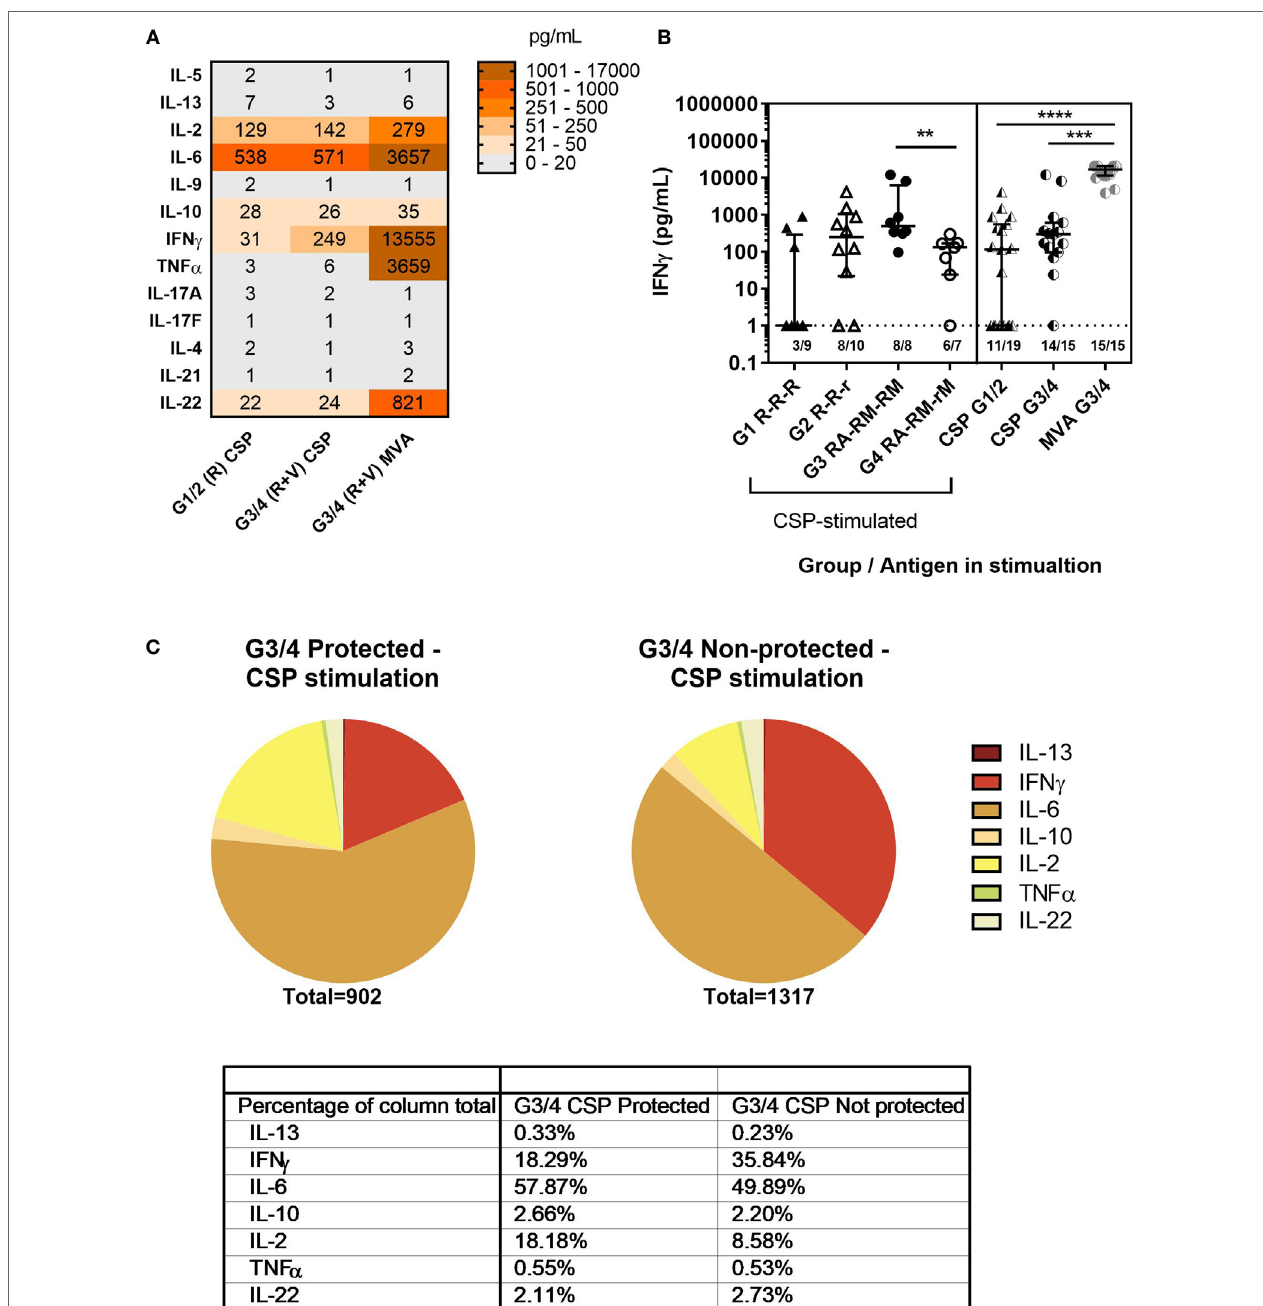
FigUre 5 | Cytokine responses to CSP and MVA. Cytokine responses measured in supernatant after stimulation of 1–2 × 10 6 PBMC at C-1 with CSP or MVA. A multiplex cytokine bead assay (Legendplex, BioLegend) was used to measure a panel of T-helper cytokines. Responses were measured for 19 G1/2 samples stimulated with CSP and 15 G3/4 samples for which there were enough cells to run both CSP and MVA stimulations. (a) Heatmap of geomean cytokine concentrations in pg/mL in supernatant of PBMC from G1/2 stimulated with CSP and G3/4 stimulated with CSP or MVA. (B) Concentration of IFN γ in supernatant of PBMC stimulated with CSP or MVA, Kruskal–Wallis with Dunn’s multiple comparisons P < 0.0001. Mann–Whitney analysis between G3 RA-RM-RM and G4 RA-RM-rM P = 0.0037. Lower limit of detection for all cytokines in this assay was 1 pg/mL (indicated by the dashed line). (c) Proportions of cytokines produced in response to CSP stimulation (geomeans) in G3/4 (R + V) volunteers who were protected compared with those who were not. Table shows the level of each cytokine produced as a percentage of the total cytokine response to CSP in each group. Abbreviations: R G1/2, RTS,S/AS01B vaccinated; R + V G3/4, RTS,S/AS01B and viral-vectored vaccines co-administered; R2V, RTS,S/AS01B and viral-vectored vaccines at a 2-week stagger; A, ChAd63 ME-TRAP; M, MVA ME-TRAP; R, 50 µg third dose of RTS,S/AS01B; r, 10 µg third dose of RTS,S/AS01B; CHMI, controlled human malaria infection; C-1, day before CHMI; CSP, circumsporozoite protein; PBMCs, peripheral blood mononucleocytes; TRAP, thrombospondin-related adhesive protein.